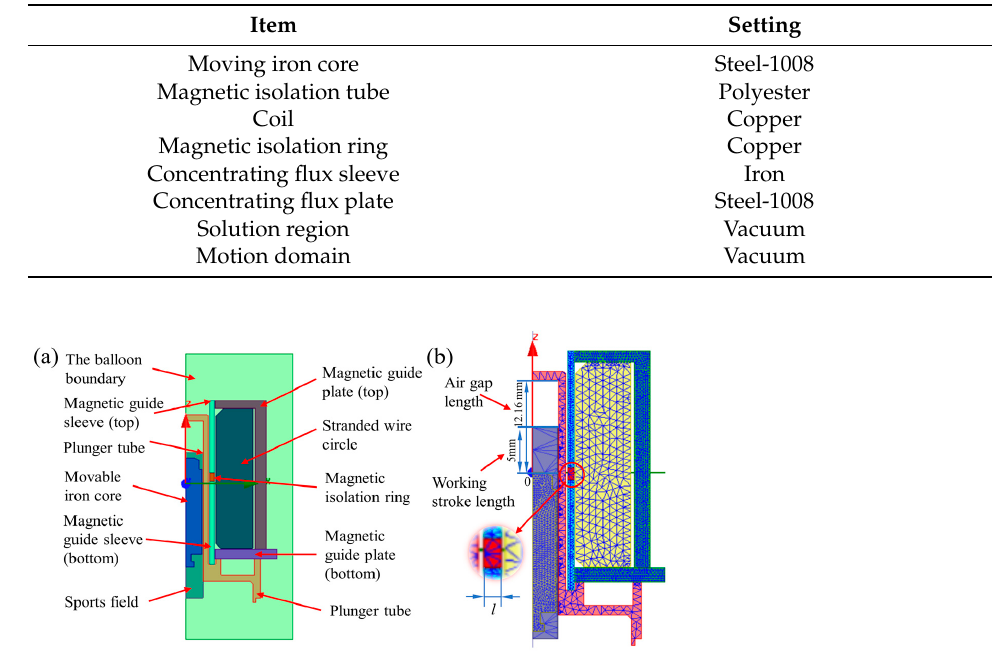
Figure 2. ( a ) Solution settings and ( b ) the meshing length of the magnetic conductive material is set to 0.5 mm, and the rest are set to 1.5 mm. The coil is set to add heat form, and the number of turns is set to 2700. A winding is defined as an external circuit with an initial voltage of 0. The external circuit setting form is shown in the figure. The internal division based on length is selected as the meshing form. The movable iron core and the magnetic conductor are our key observation objects for the magnetic ring. The meshing of the model is shown in Figure 2b. The free meshing method is adopted to mesh the solenoid valve. The meshing density of magnetically con ‐ ductive material should be larger to improve the simulation accuracy, which is set to 0.5